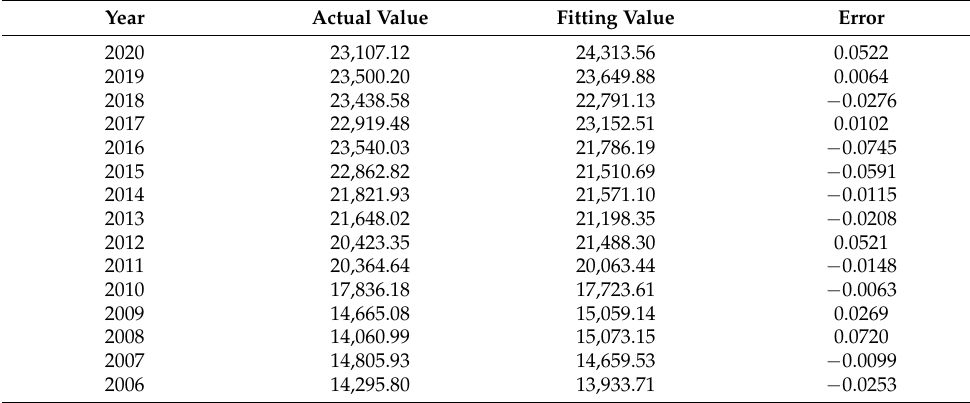
Table A4. Relative error table of fitting value of STIRPAT model.